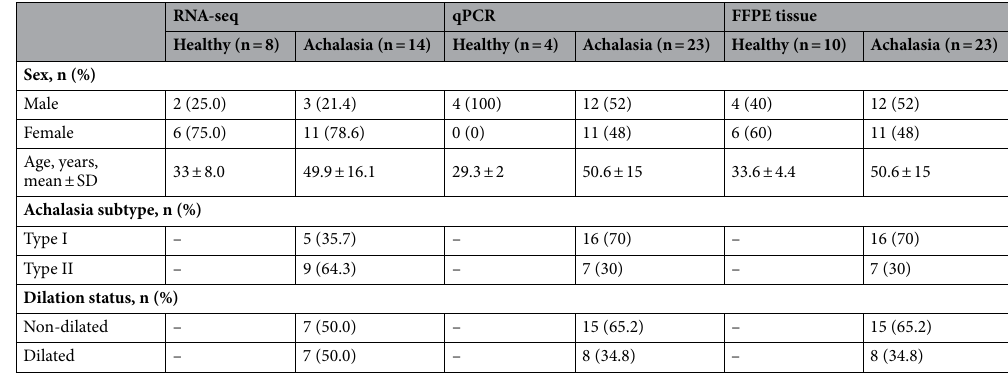
Table 1. Clinical characteristics of enrolled